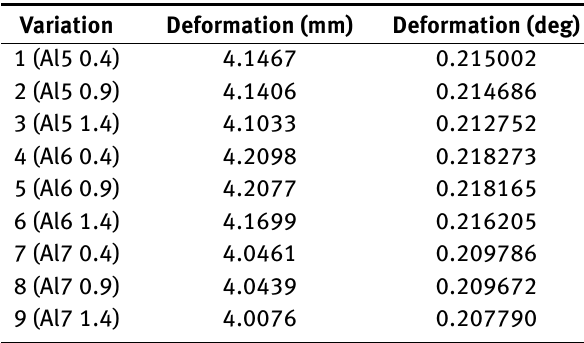
Table 9: Summary of the chassis